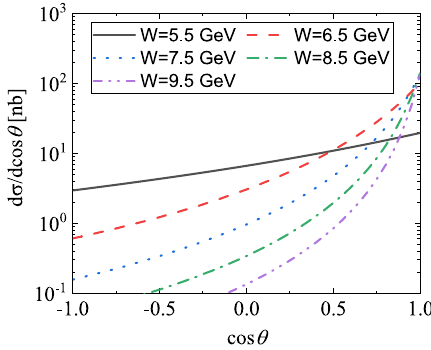
Fig. 4 The differential cross section d σ/ dcos θ of the X 1 production in K + p collisions at different center-of-mass energies with α = 1 . 5